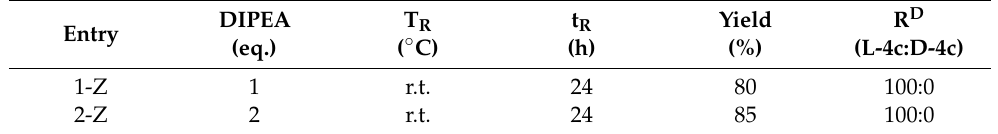
Table 2. Specifics for N -Cbz- L -phe and 1 coupling in the presence of TBTU/DIPEA. T R = reaction temperature, t R = reaction time, R D = diastereoisomeric ratio ( L-4c : D-4c ).